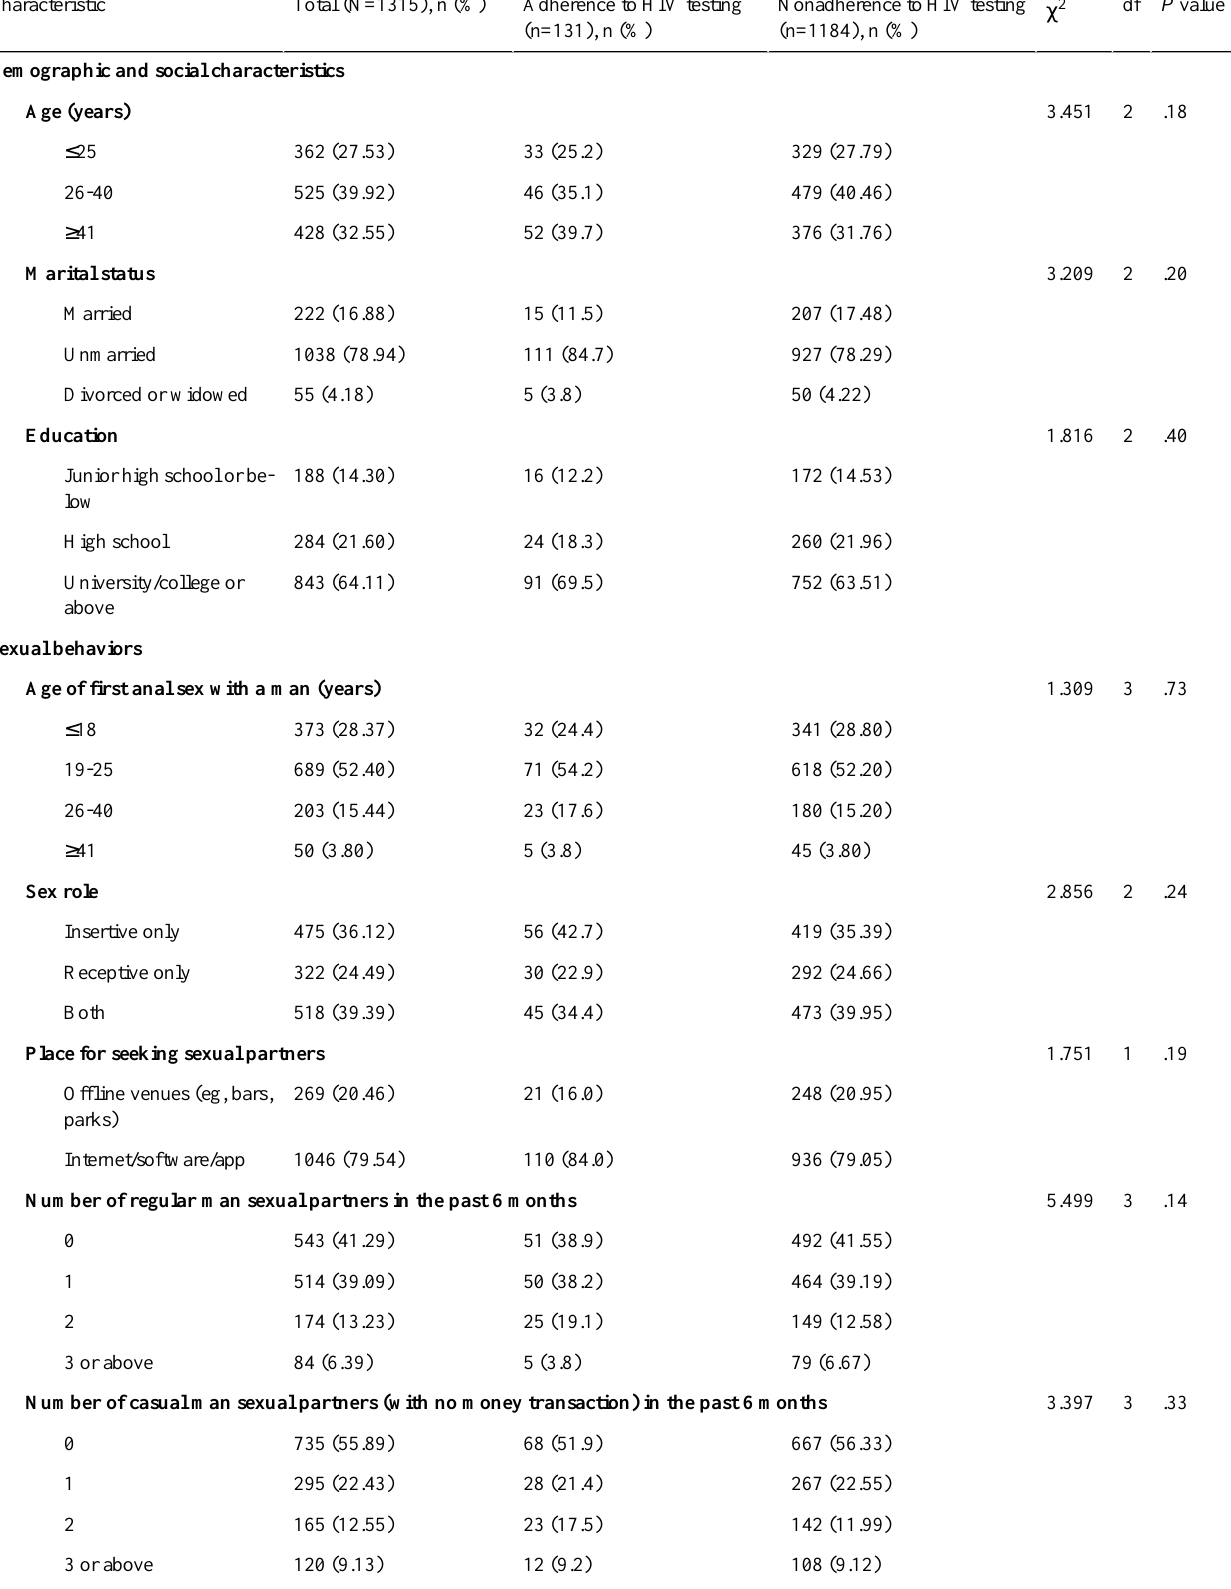
P valuedf χ 2 Nonadherence to HIV